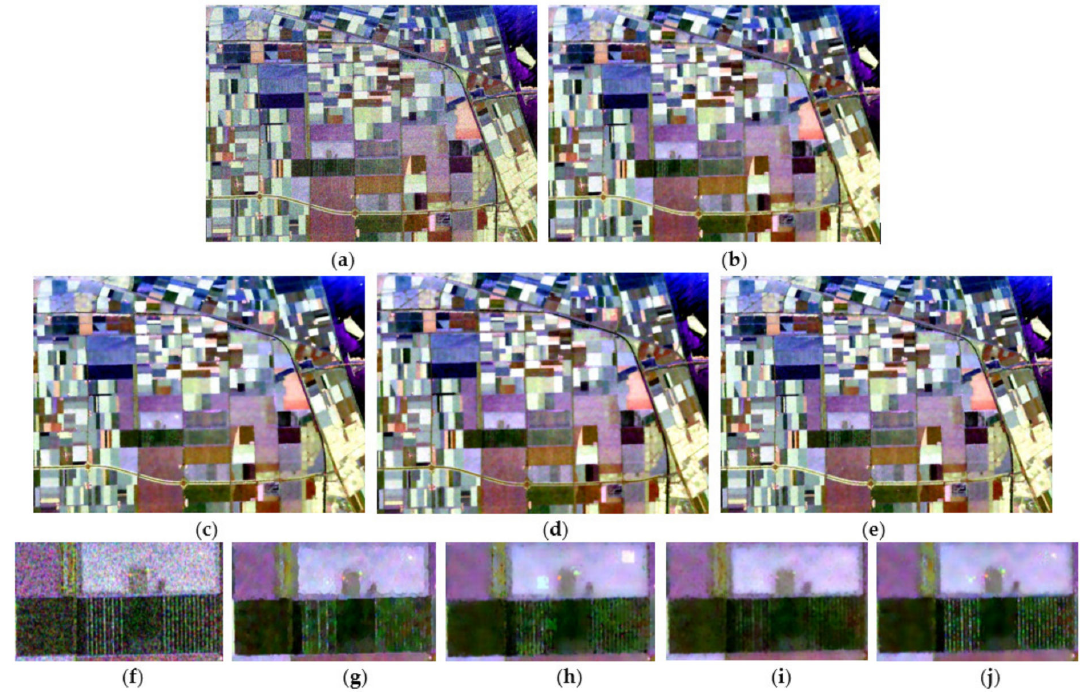
Figure 3. The filtering results for the Flevoland data set: ( a ) Pauli RGB image of the original data; ( b ) the result of the refined Lee filter shows a scalloped appearance in the image; ( c ) the result of NL-means has a remarkable performance in speckle reduction, but some details are overly smoothed and isolated point targets are smeared; ( d ) the image filtered by the NLTV shows the over-smoothing problem; ( e ) the image filtered by the proposed method is good with regard to both reduced speckle and retained details; and ( f – j ) detailed regions cropped from ( a – e